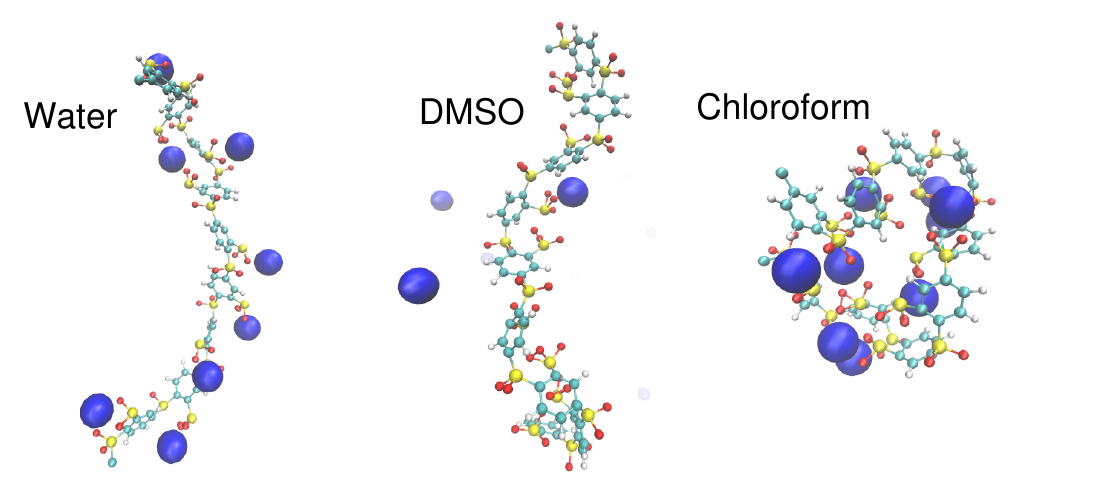
Figure 2. Simulation snapshots of sulfonated oligosulfonic acids with sodium counterions (blue spheres) in water ( left side ), dimethyl sulfoxide (DMSO) ( middle panel ), and chloroform ( right side ). Solvent molecules are ignored for the sake of clarity. Figure reproduced from Ref. [18].